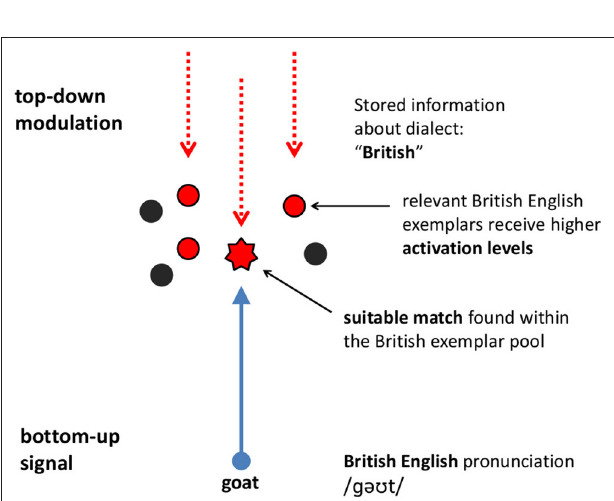
FIGURE 5 | Match finding in the presence of top-down modulation and richly indexed exemplars. Modified from Lewandowski (2012), employing an ART framework ( Grossberg, 2003).